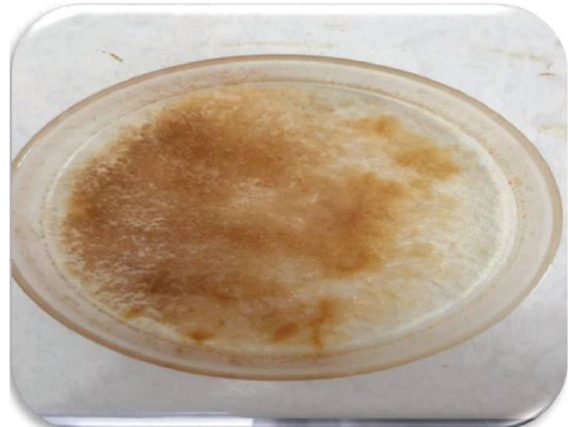
Figure 13: Partially purifed biosurfactant using the acid pre- cipitation and chloroform:methanol (2:1 v/v) solvent extraction method.